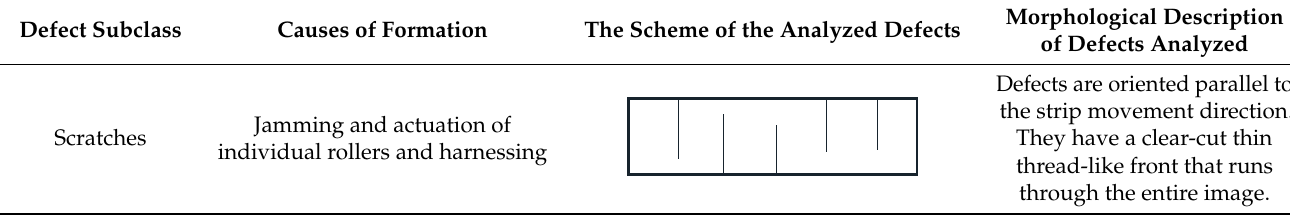
Morphological Description of Defects Analyzed